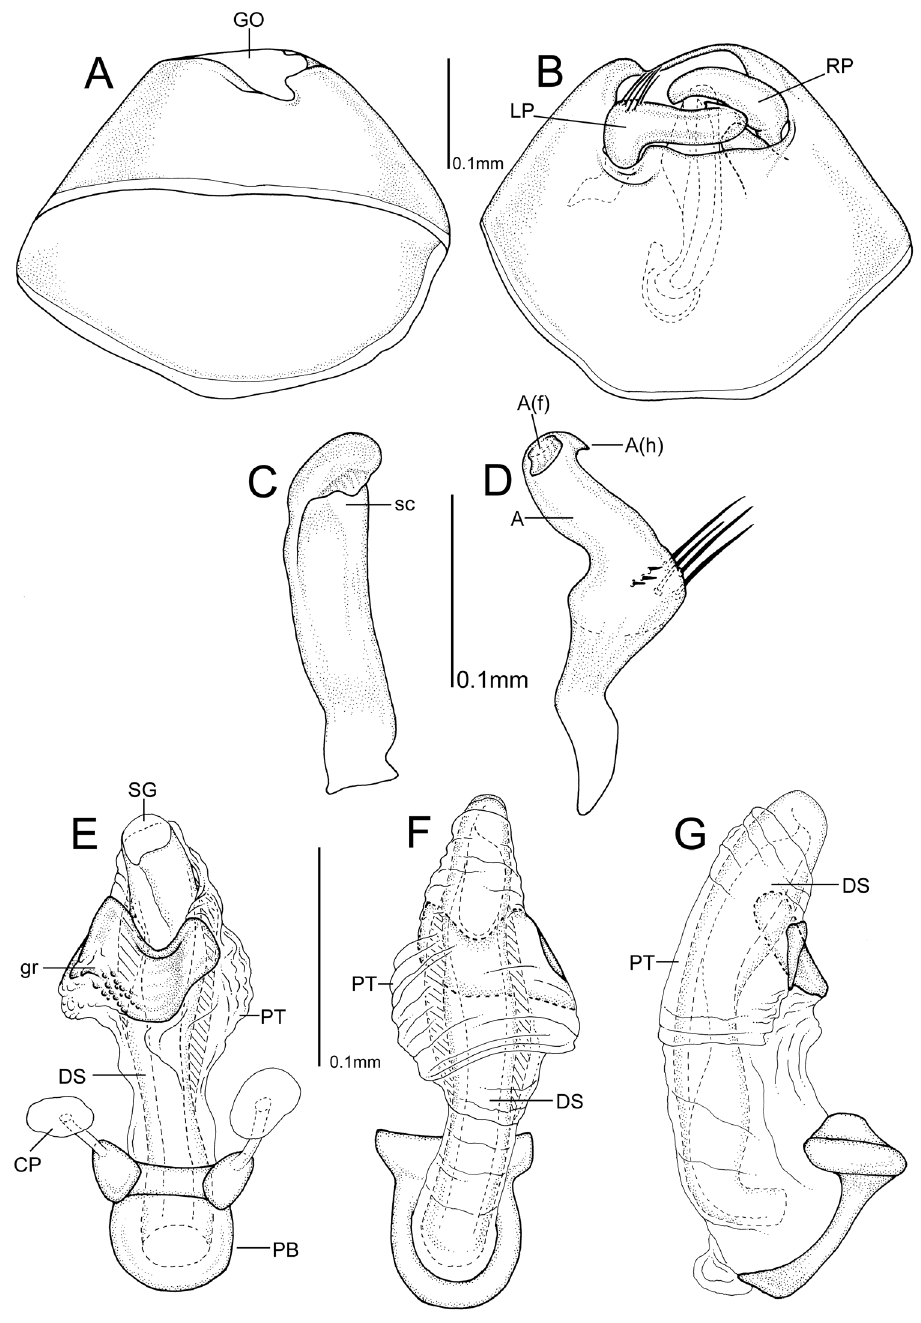
Figure 3. Male genitalia of Henryhalticus philippinensis gen. et sp.